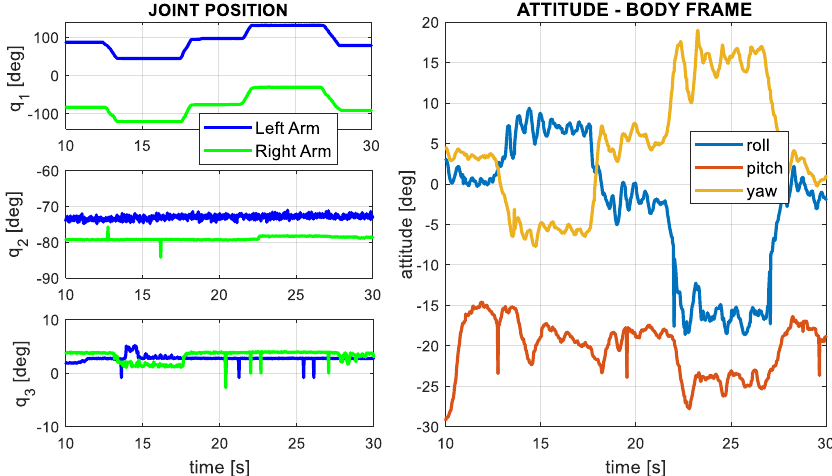
Figure 17. Joint position of the left and right arms and attitude of the body frame when the arms generate a rolling manoeuvre, inducing a lateral force.